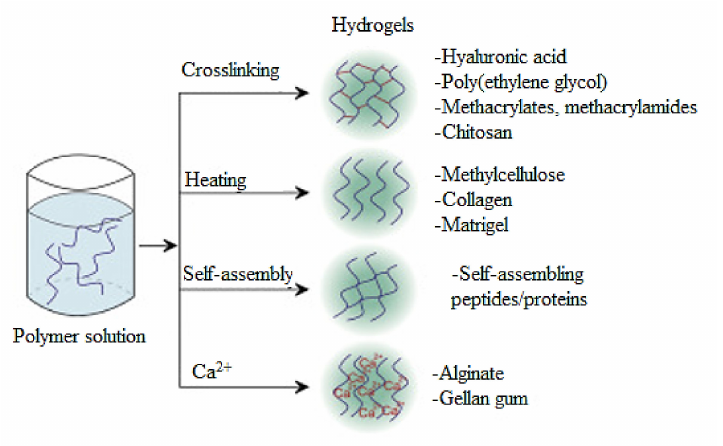
Figure 2. The main crosslinking methods are used for the development of hydrogels [78].